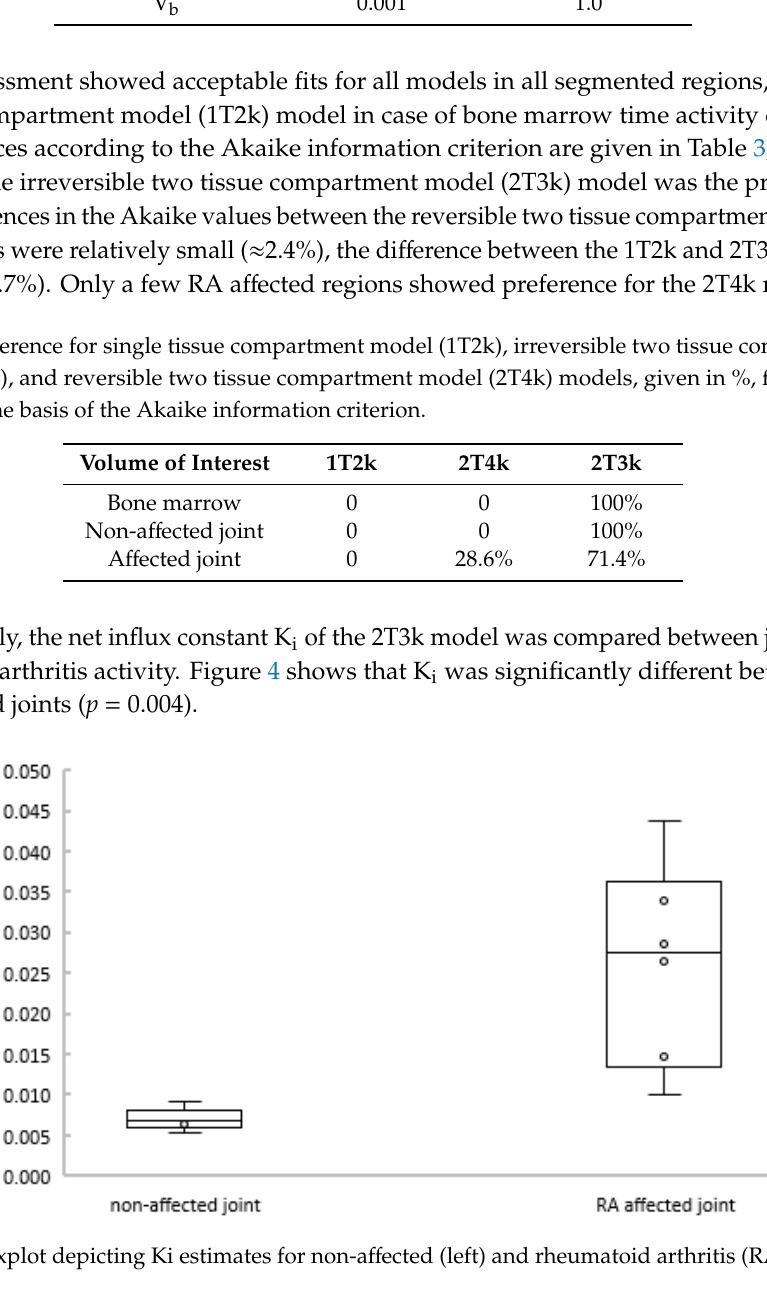
Figure 3. Average percentage of parent fractions in plasma (dots) with one SD range (error bars) as function of time (min).